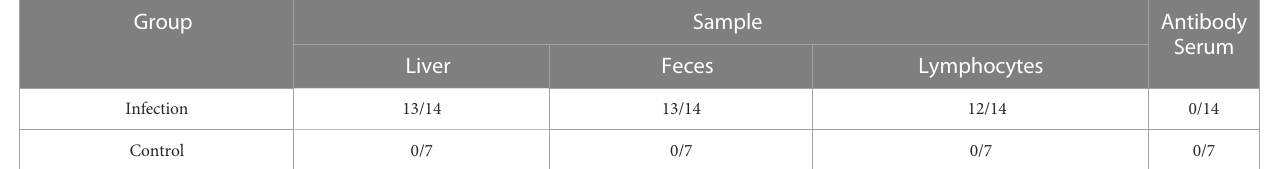
TABLE 1 Detection of HEV RNA and